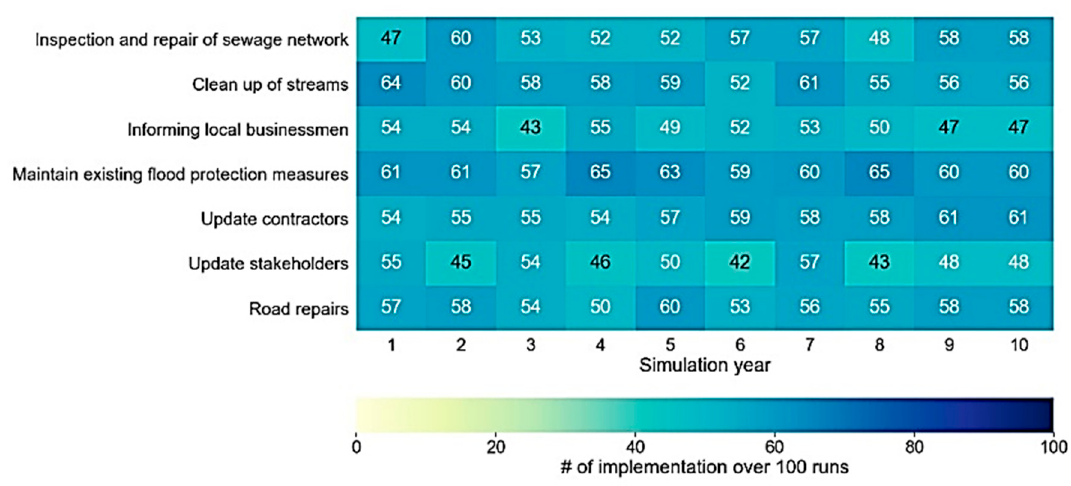
Figure 13. Heatmap of how many times (#) actions have been implemented per simulation year with annual low flood severity (T < 100 year-flood) and just enough funding.